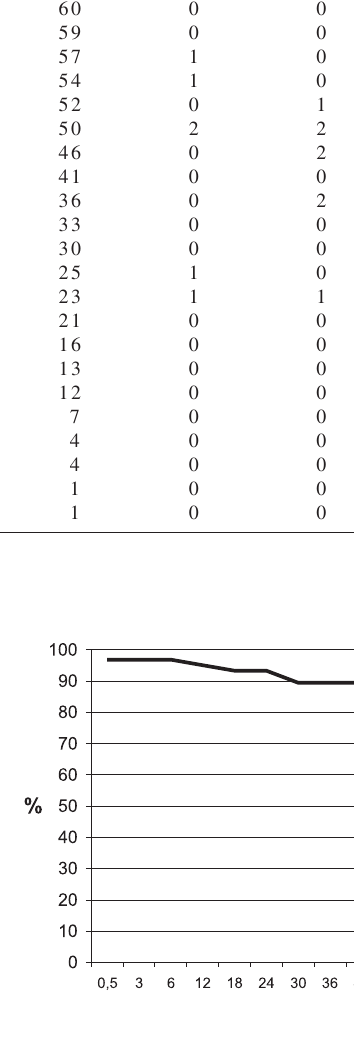
Figure 2 - Cumulative primary patency rates of 62 consecutive angioplasties performed for intermittent claudication.